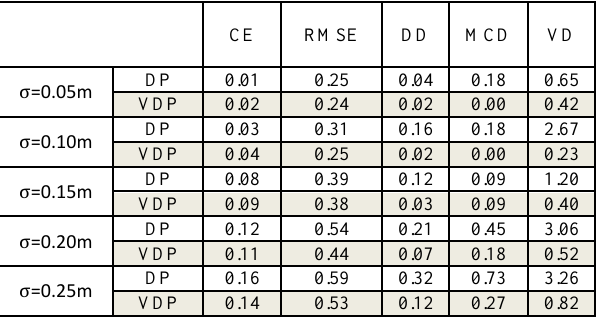
Table 1: Statistical assessment under various Gaussian noise levels.